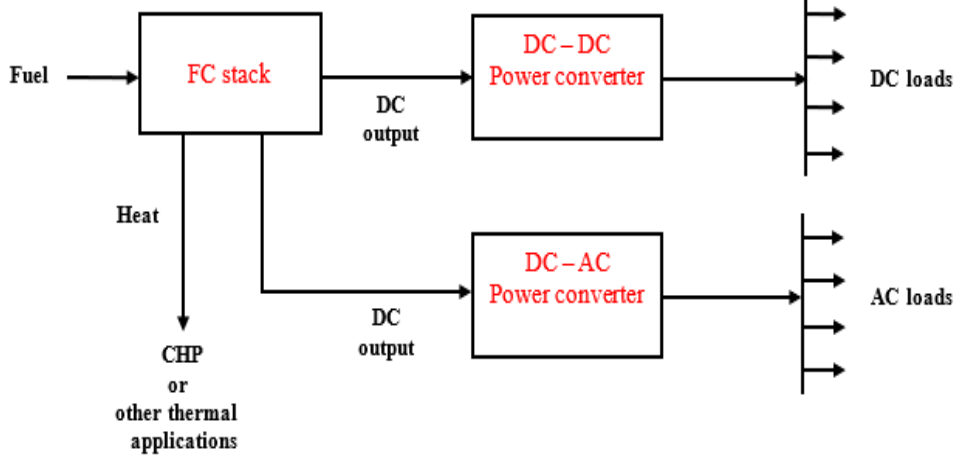
Figure 2. Schematic of the FC microgrid system.